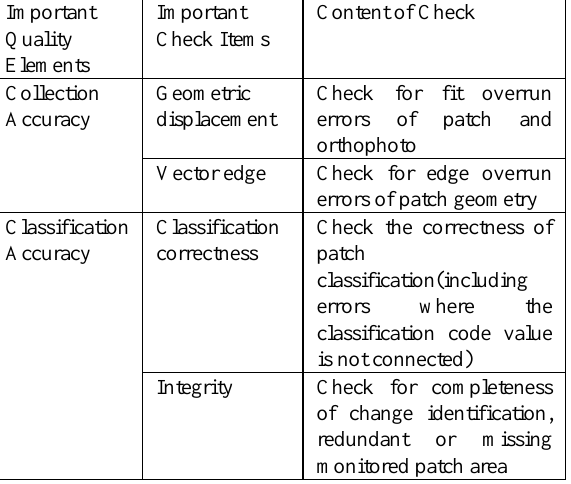
Table 1. Content of quality review of land cover classification